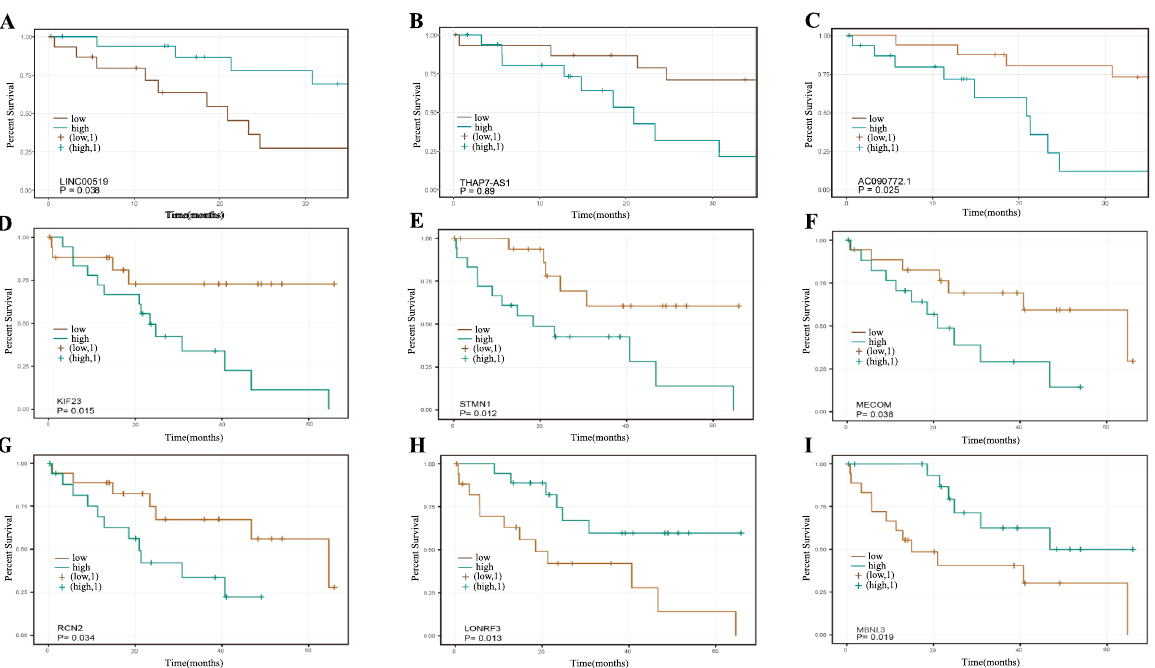
Figure 5. Kaplan–Meier survival analysis of survival-significant DElncRNAs using R “survival” package version 3.2–11, < URL: https:// CRAN.R- proje ct. org/ packa ge= survi val > : LINC00519, THAP7-AS1, AC090772.1( A – C